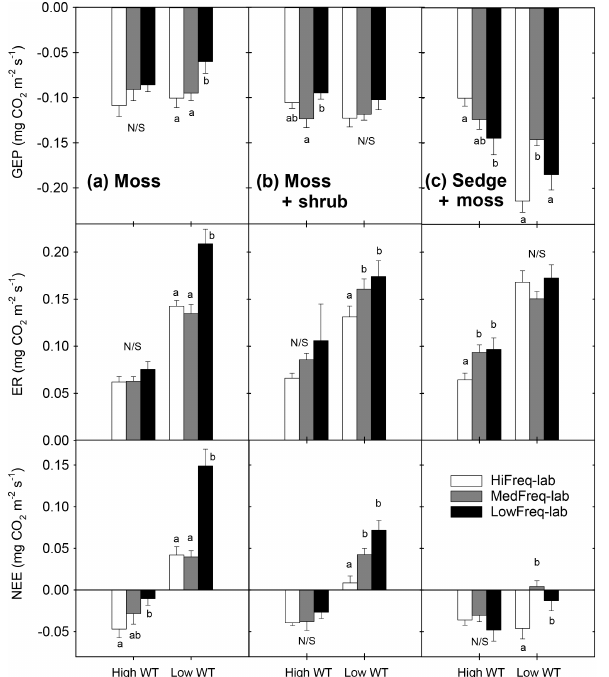
Figure 4. Comparison of mean GEP, ER, and NEE between rain- fall treatments within each WT treatment for each vegetation com- munity: (a) moss, (b) moss + shrub, and (c) sedge + moss. Error bars represent the standard error of the mean. Negative NEE rep- resents net CO 2 uptake. Different letters indicate significant differ- ences ( p < 0 . 05) between treatments within each WT period.